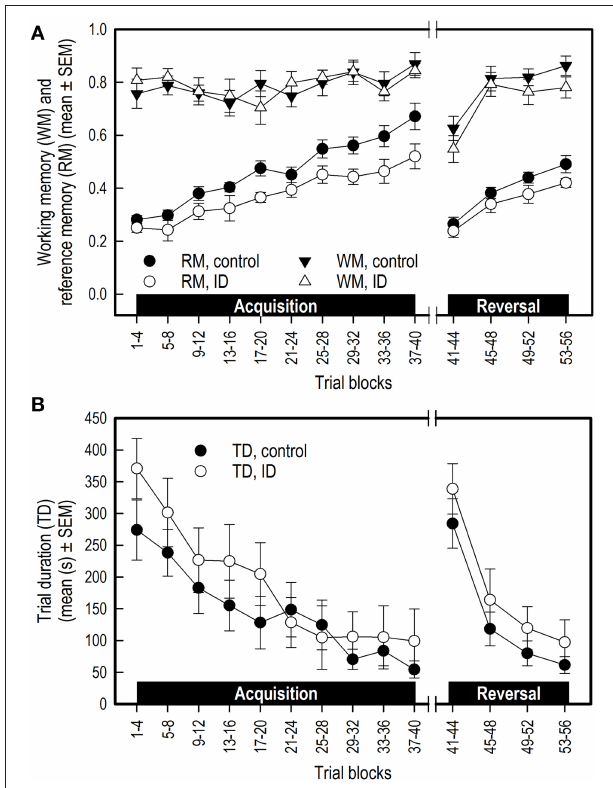
FIGURE 4 | Performance of ID ( n = 8 ) and control ( n = 10 ) piglets in the spatial cognitive holeboard task during the acquisition phase (trials 1–40) and the reversal phase (trials 41–56). (A) Working memory (WM) and reference memory (RM) performance. ID animals showed impaired RM performance in the acquisition, transition and reversal phase; see Supplementary Table 2 for results of the statistical analyses. (B) Trial duration (TD). Note that TD was analyzed statistically after log 10 transformation whereas the untransformed means and SEMs are depicted